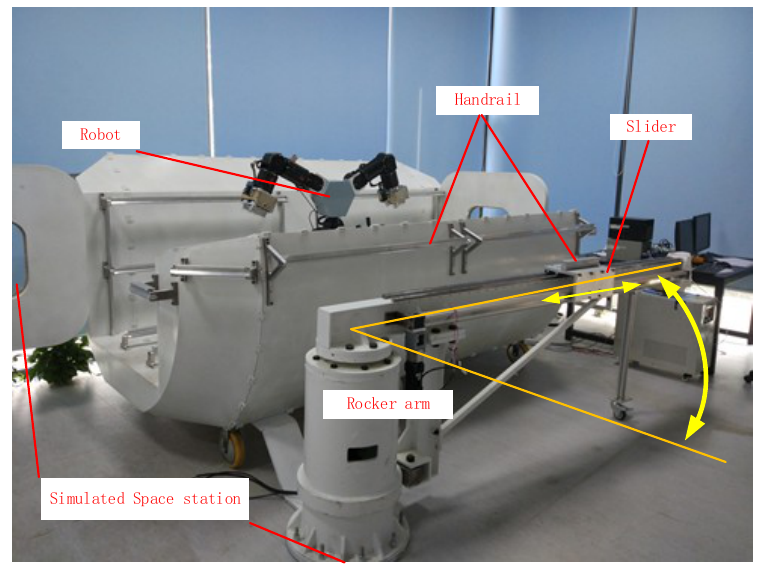
Figure 7. The actual test environment of the robot.